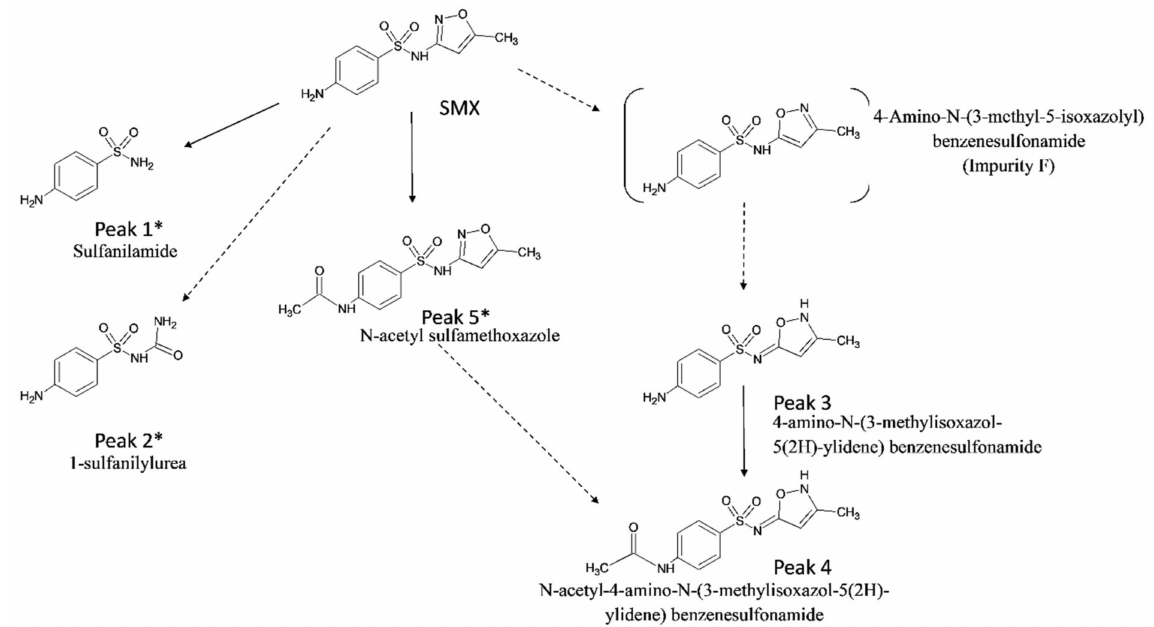
Figure 3. Proposed degradation scheme of sulfamethoxazole (SMX) during meat cooking. (* identity confirmed by comparison of chromatographic retention time and MS/MS spectra with an available standard